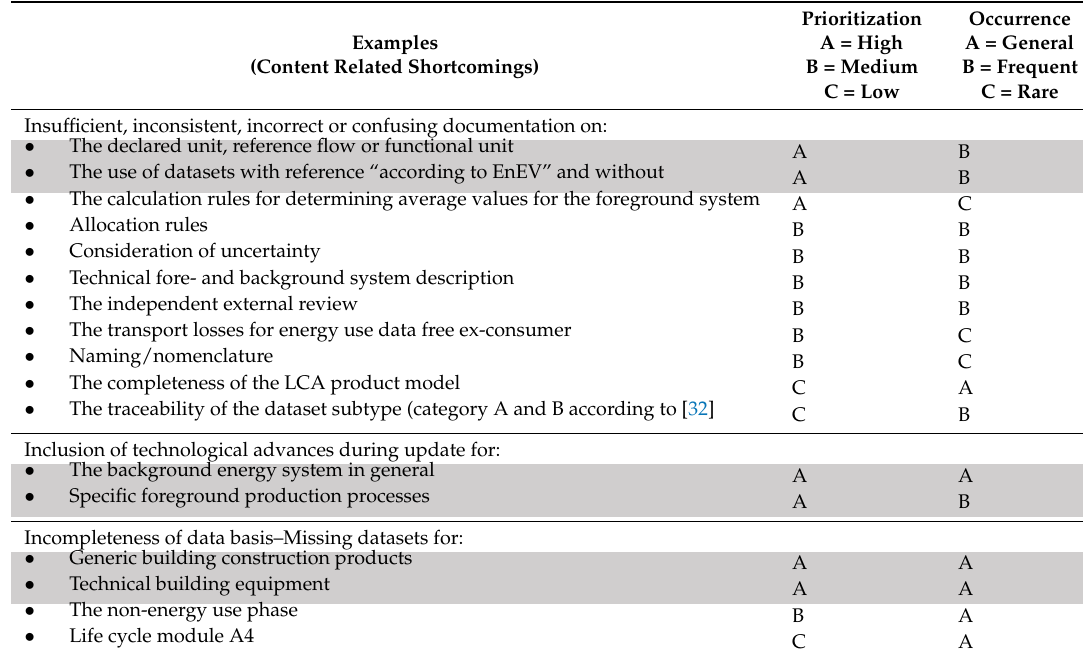
Table 3. Content related shortcoming–Examples and their prioritization for solution-oriented